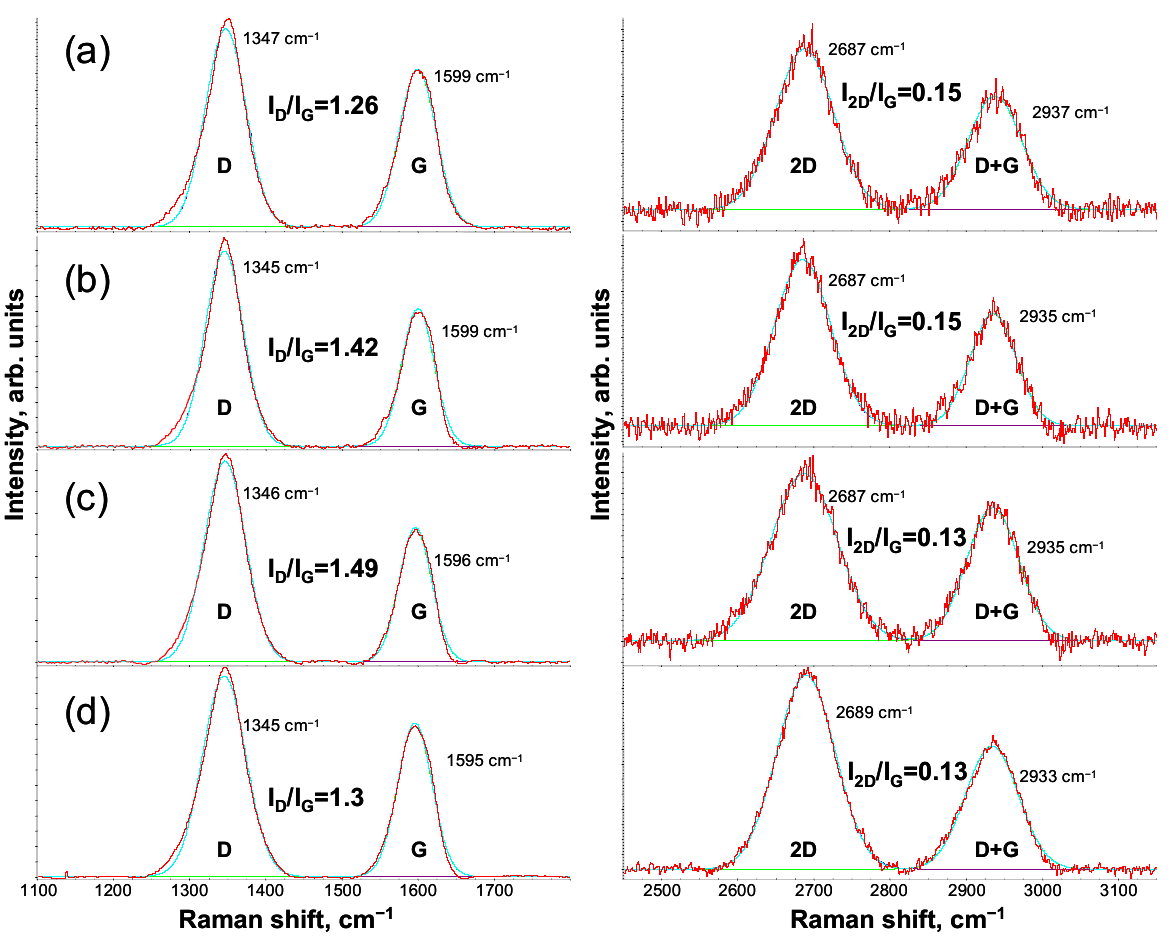
Figure 2. Raman spectra of pristine graphene ( a ), N35 ( b ), N75 ( c ), and N110 ( d ) recorded at 532 nm excitation wavelength and presented in two actual wavenumber ranges.